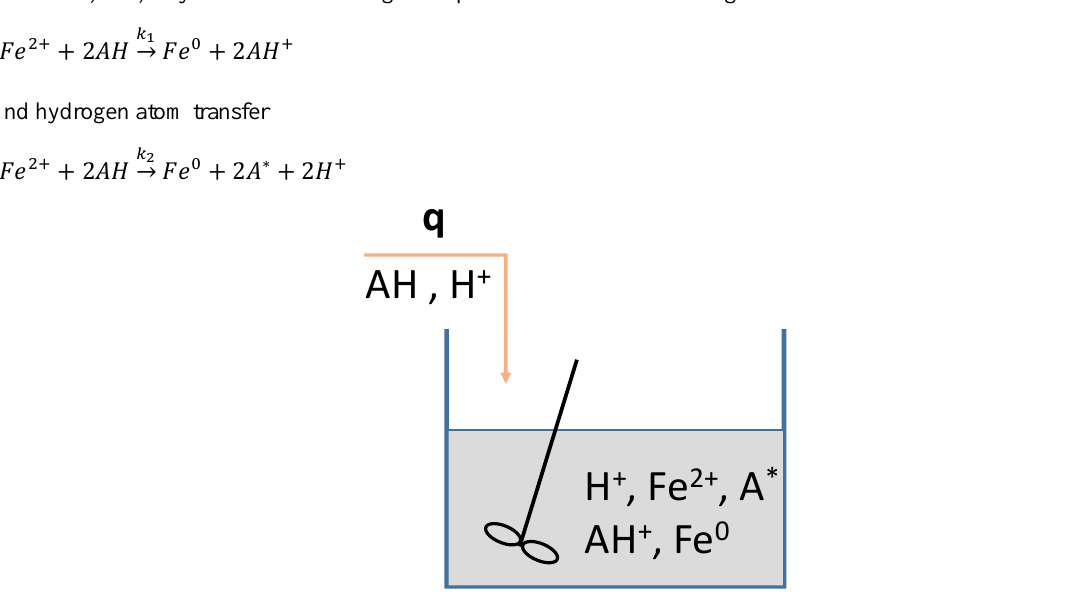
Figure 2. Simplified representation of a semi-batch reactor, where the polyphenol solution is injected in the iron salt